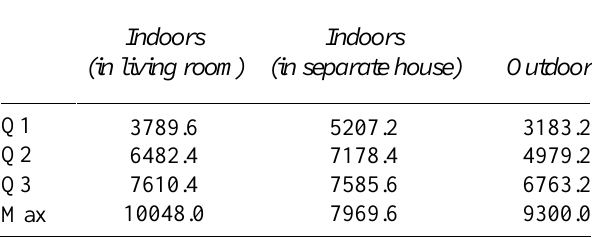
Table 4: PM peak concentration ( µg/m 3 ) recorded during 10 cooking in different kitchen locations